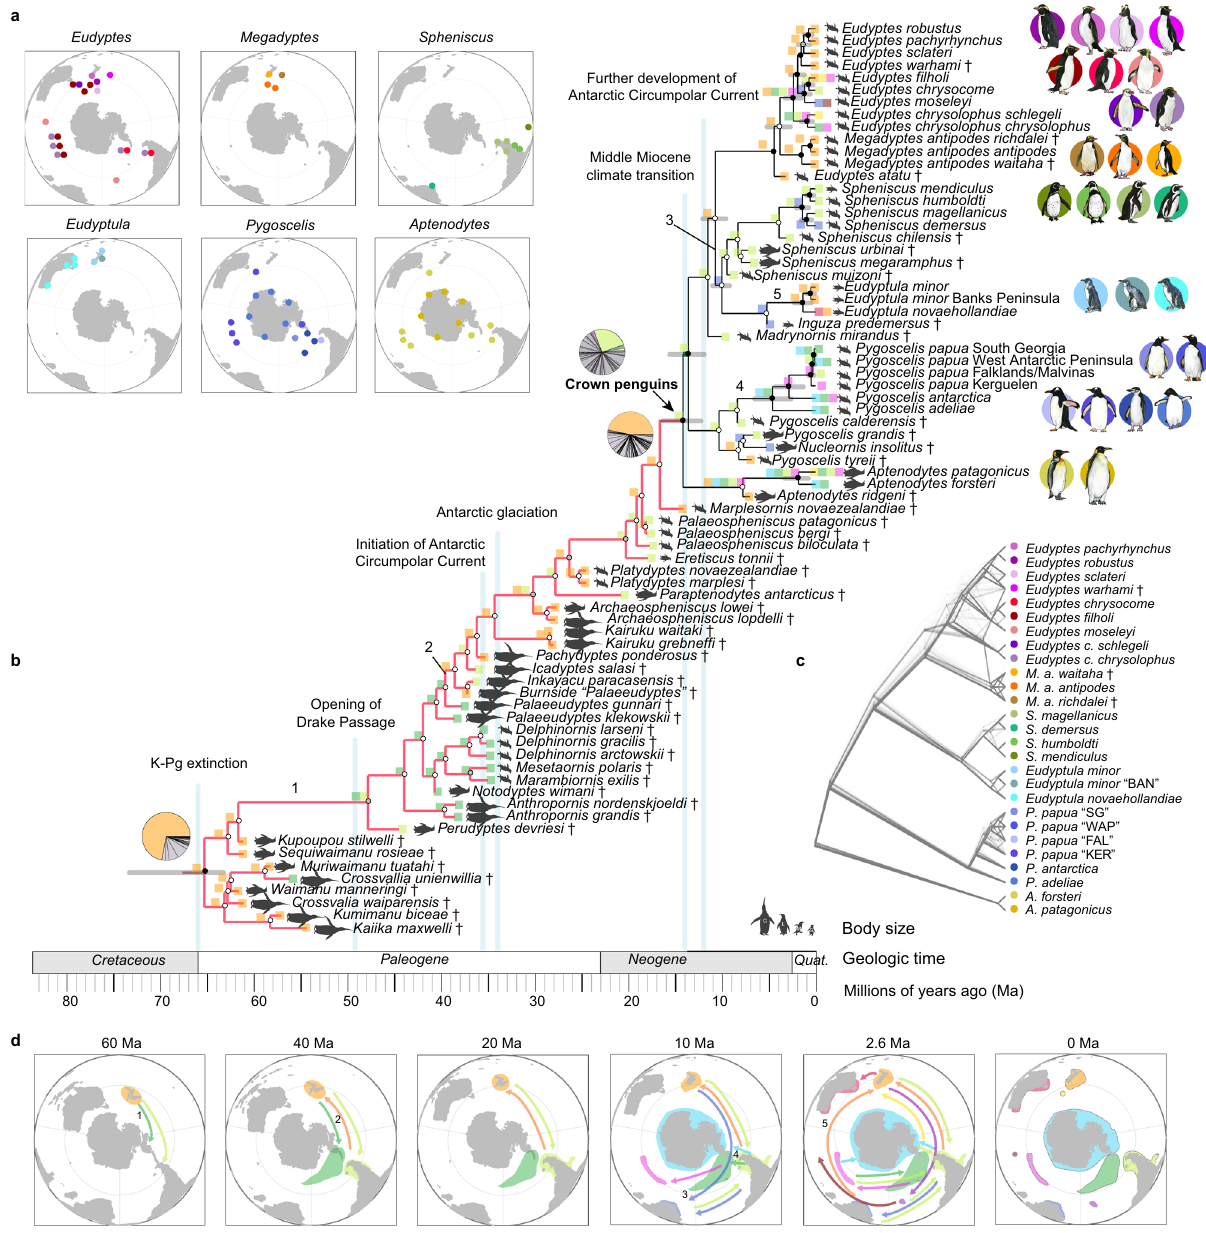
Fig. 1 Phylogeny and biogeography of penguins. a Breeding range of extant/recently-extinct penguins. Colors of circles correspond to species identities shown in subplot b , c . Note, Eudyptula novaehollandiae and Megadyptes antipodes antipodes colonized New Zealand <800 years ago, so those expanded ranges are not shown. b Total-evidence maximum clade credibility tree incorporating ancestral range estimation from BioGeoBEARS under the best- fi tting model (DEC + J + X). † indicates extinct taxa. Silhouettes in cladogram indicate approximate body size. The gray rectangles at the nodes among extant penguins represent 95% con fi dence intervals of the corresponding estimated divergence times. Circles at the nodes are colored to indicate posterior probability: black (>0.95), gray (0.75 – 0.95), white (<0.75). The single most probable ancestral range is indicated at each node using squares (colors represent the ranges in d ) with the exception of three key nodes (pie charts, gray represents multiple ranges). Nodes are marked with a number corresponding to potential dispersal events. Major geological events are indicated. c Densitree of 500 random RAxML gene trees, summarizing gene discordance. d Paleomaps showing major inferred dispersal vectors for penguins across the Cenozoic. Arrows show one possible biogeographic scenario interpreted from the ancestral area reconstructions. Numbers correspond to numbered nodes in b . Source data is provided as a Source Data fi le.